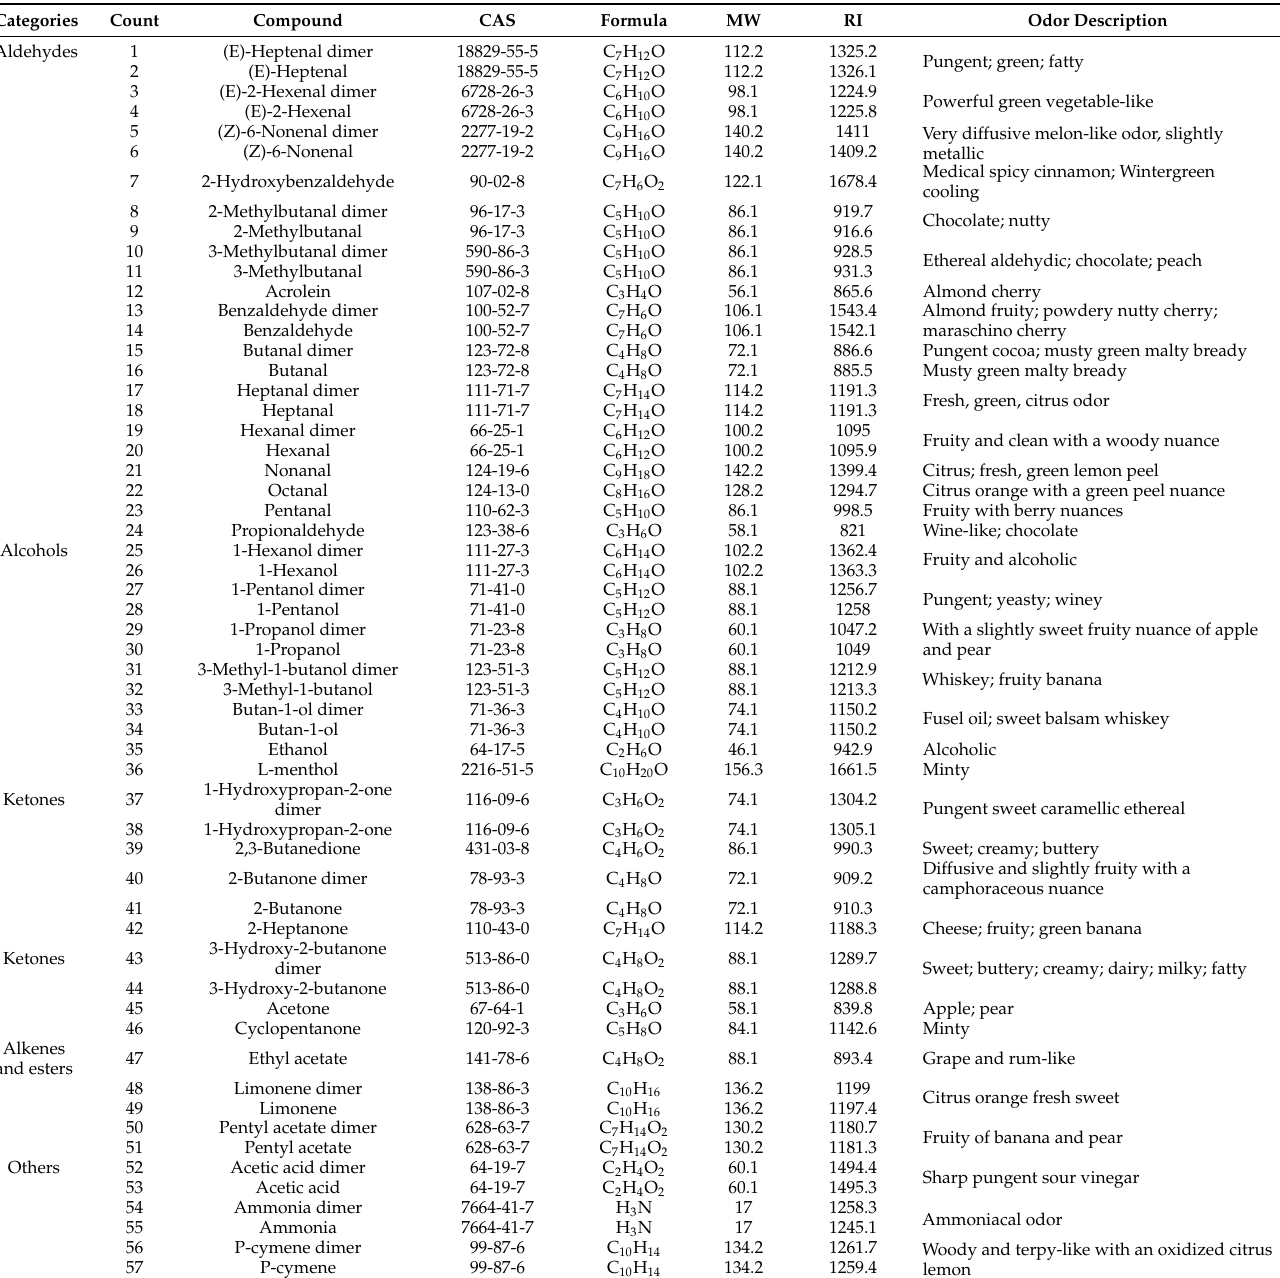
Table 2. Identification of volatile flavor compounds in L. decastes with different drying method